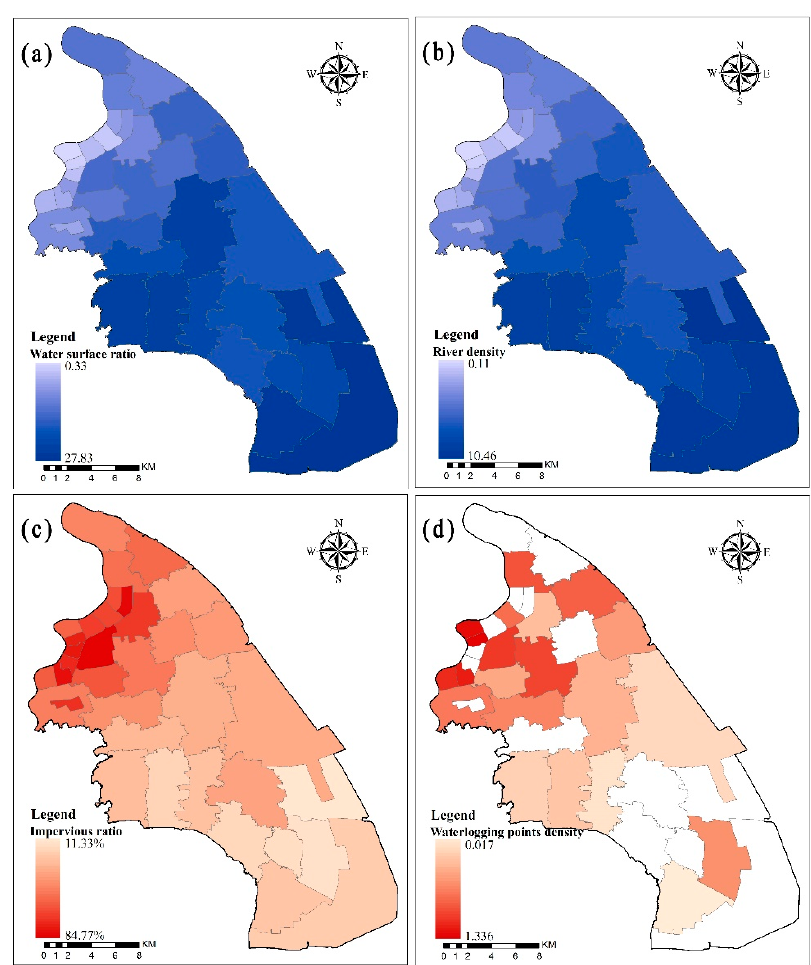
Figure 4. Characteristics of the Pudong New Area. ( a ) Water surface ratio of the Pudong New Area; ( b ) River density of the Pudong New Area; ( c ) Impervious ratio of the Pudong New Area; ( d ) Waterlogging points density of the Pudong New Area.